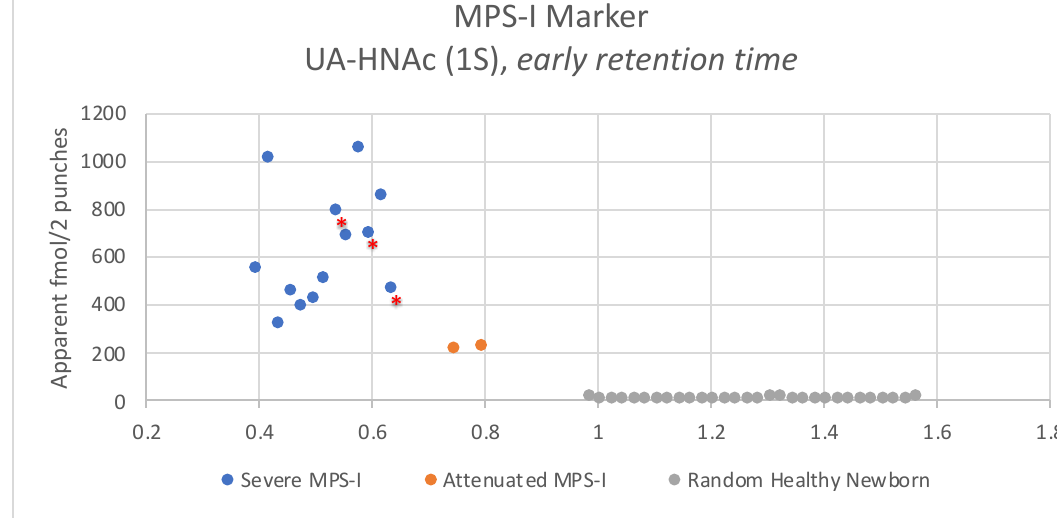
Figure 4. Levels of endogenous disaccharide biomarker UA-HNAc(1S) PMP derivative in newborn DBS from 30 random newborns (non-MPS-I), from 13 newborns with severe MPS-I, and from 2 newborns with attenuated MPS-I. Asterisked dots are from newborn DBS that were stored at ambient temperature, all others were stored frozen.